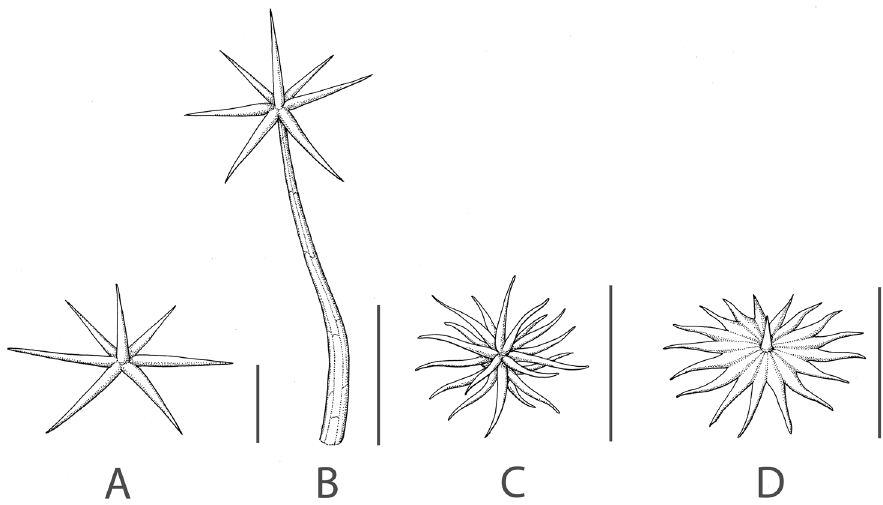
Figure 1. Trichome morphology representative of that found in members of the Elaeagnifolium clade. A Sessile porrect-stellate trichome B Stalked porrect-stellate trichome C Multiangulate trichome D Lepi- dote trichome. Scale bars = 0.5 mm. Reproduced with permission from Systematic Botany Monographs 99 (Vorontsova and Knapp